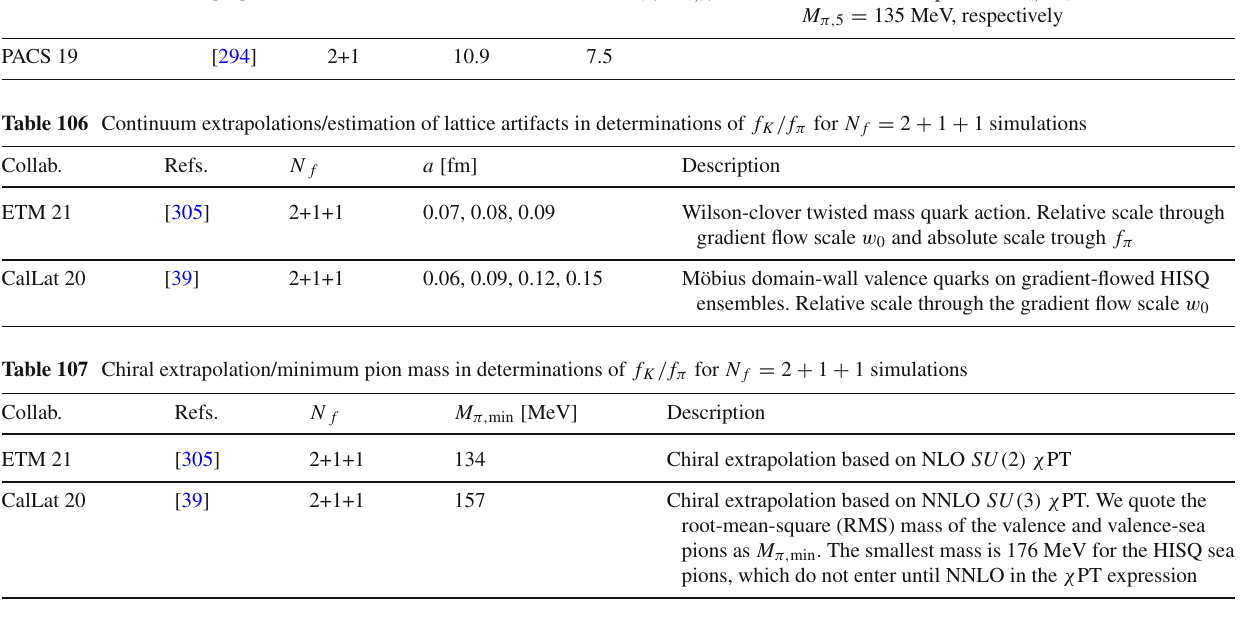
Table 108 Finite-volume effects in determinations of f K / f π for N f = 2 + 1 + 1